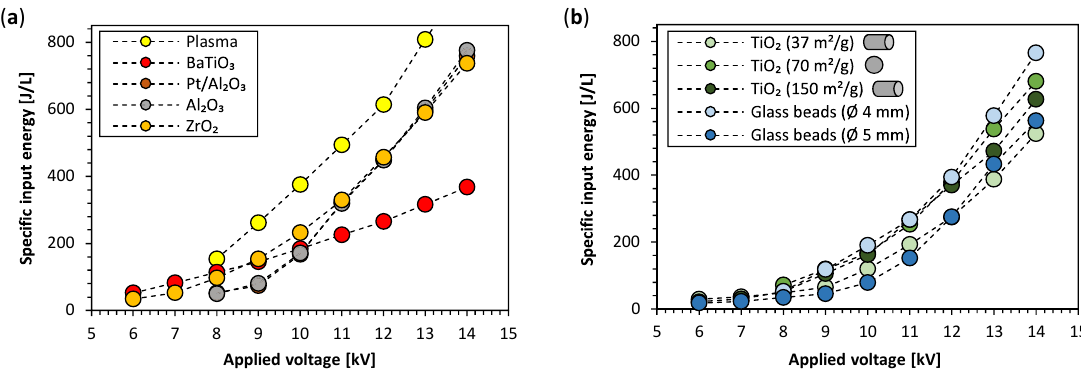
Figure 1. ( a , b ) Specific input energy as a function of applied voltage for various reactors (at 500